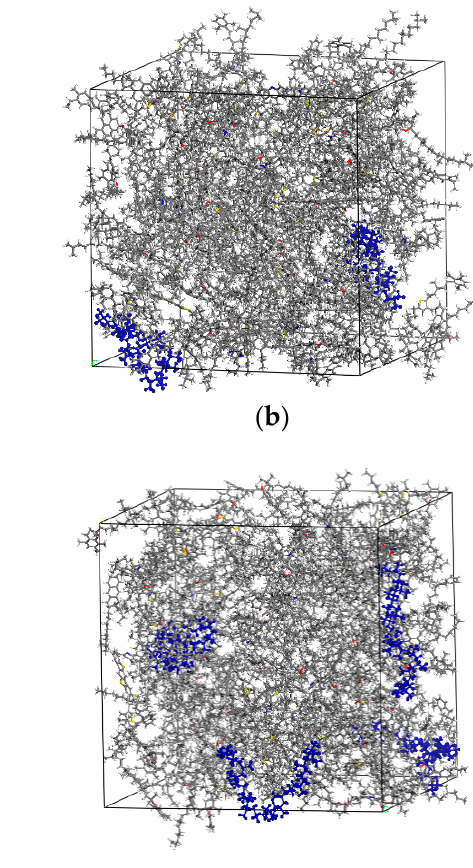
Figure 11. Solubility parameters of polypropylene.